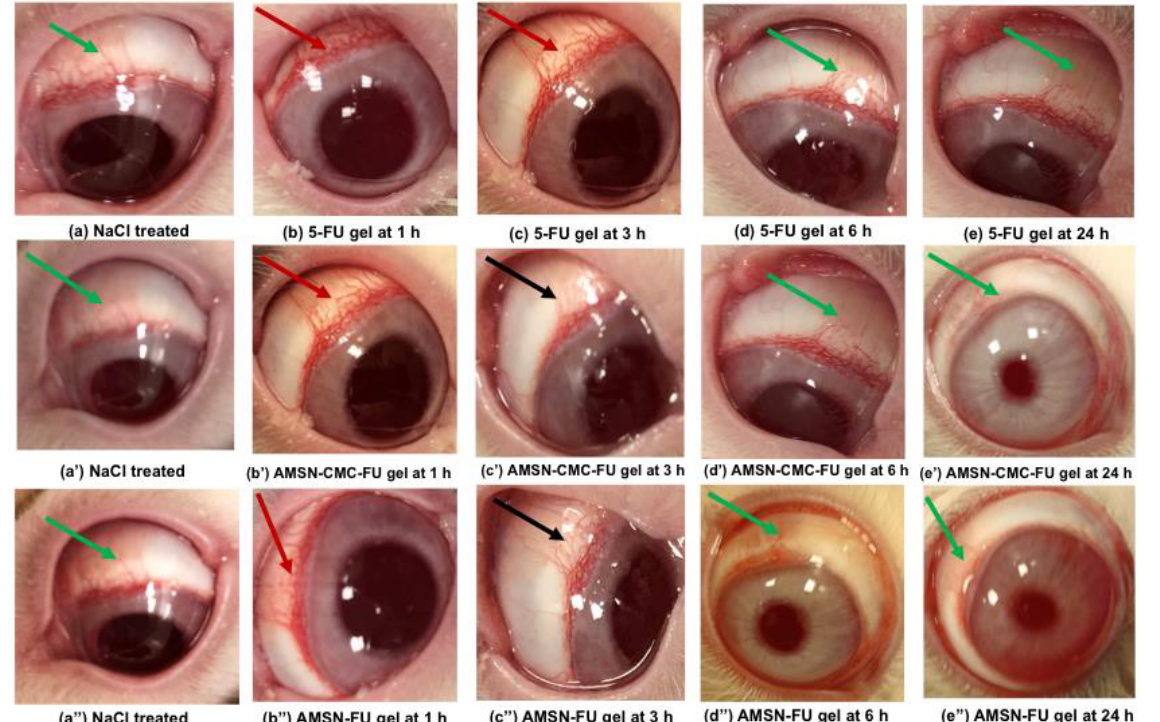
Figure 11. Eye images captured during irritation study. Representative images of normal saline- treated eyes ( a , a’ , a’’ ) (green arrows). Post topical application of 5-FU gel at 1 h ( b ) (red arrow); at 3 h ( c ) (red arrow); at 6 h ( d ) (green arrow,) and at 24 h ( e ) (green arrow). Post application of 5-FU- AMSN-CMC at 1 h ( b’ ) (red arrow); at 3 h ( c’ ) (black arrow); at 6 h ( d’ ) (green arrow), and at 24 h ( e’ ) (green arrow). Post application of 5-FU-AMSN at 1 h ( b’’ ) (red arrow); at 3 h ( c’’ ) (black arrow); at 6 h ( d’’ ) (green arrow), and at 24 h ( e’’ ) (green arrow). Green arrow: no abnormality, red arrow: moderate’s uveitis, and black arrow: mild uveitis.